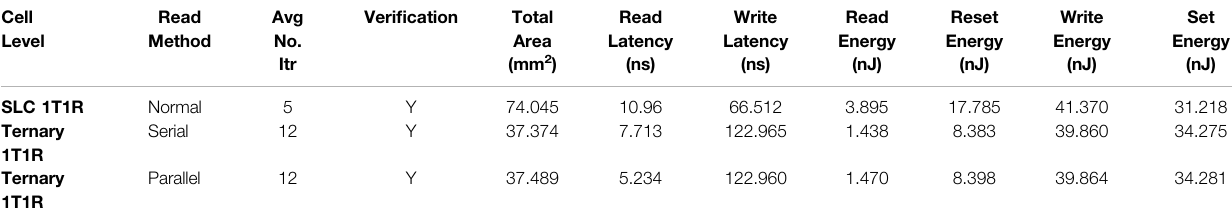
TABLE 2 | 1T1R SLC memory vs. ternary memory with serial and parallel read based on the fi rst variant of write-veri fi cation scheme. Cell Level